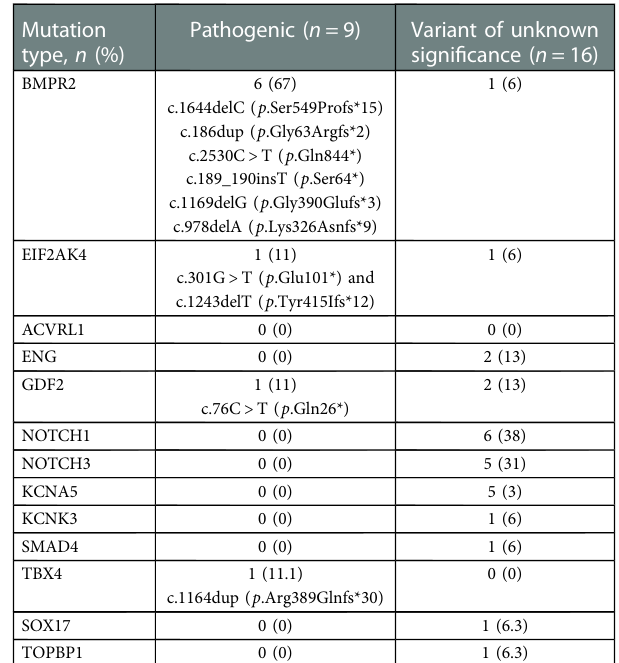
TABLE 2 Identi fi ed